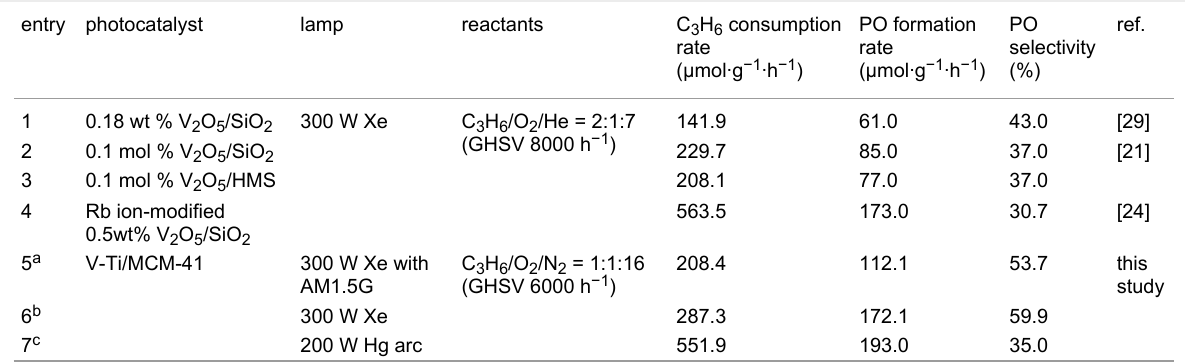
Table 3: Comparison of artificial sunlight and other light sources.